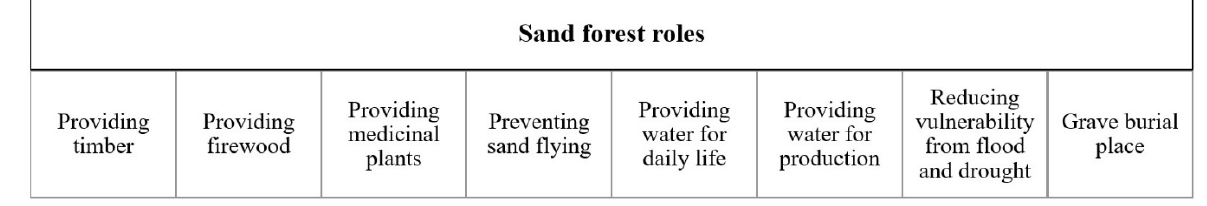
Figure 2. Roles of the sand forests in the study site.